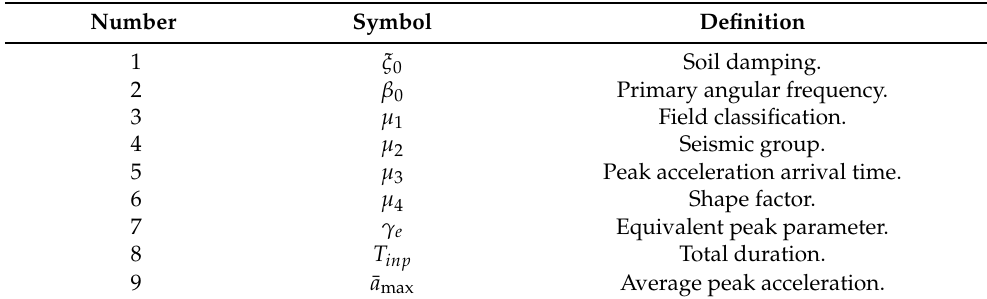
Table 1. The symbols and definitions of the stochastic earthquake model with frequency and inten- sity